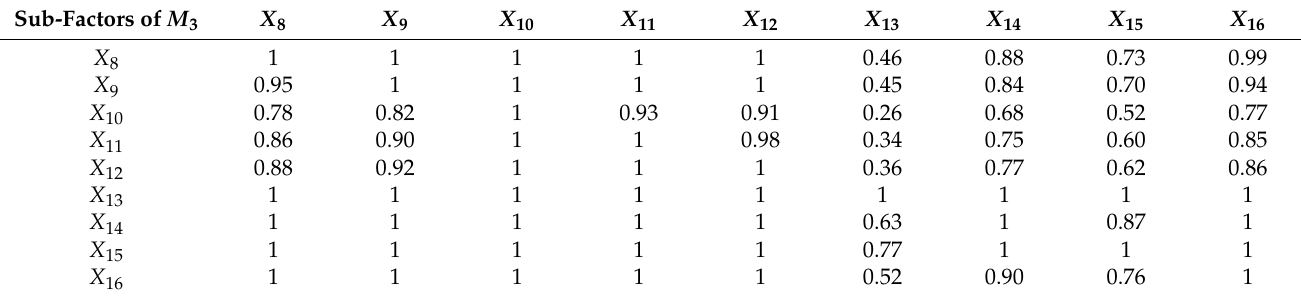
Table 10. Judgment matrix of the sub-factor layer to the upper factor M 3